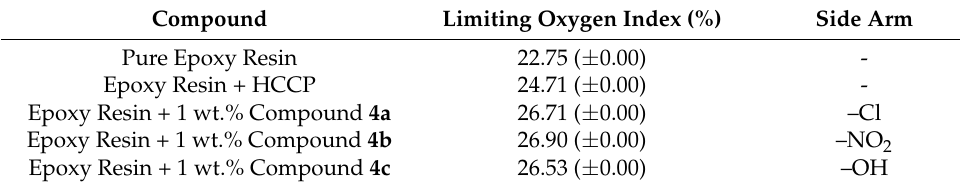
Table 3. LOI value of the compounds.